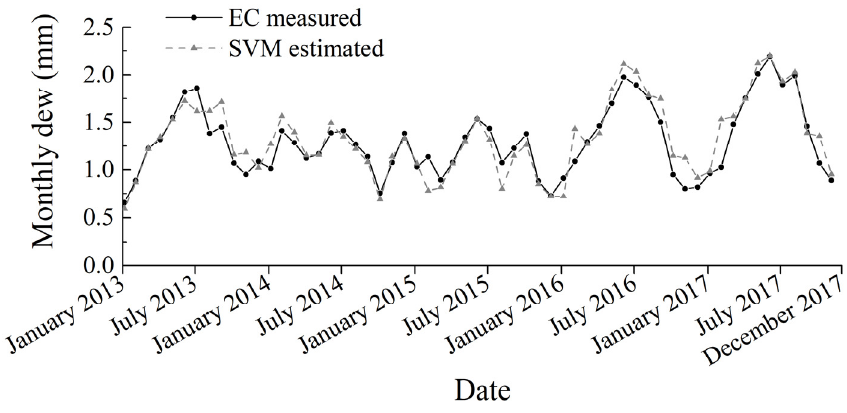
Figure 6. Site scale monthly dew SVM estimated and EC measured for 2013–2017.